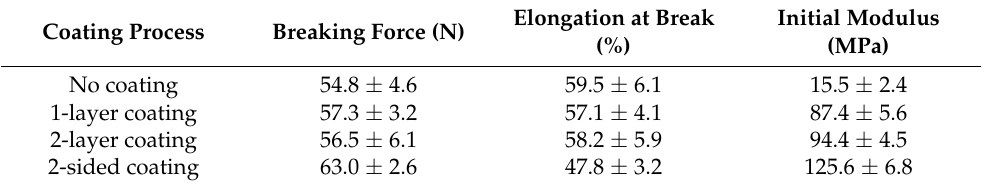
Table 2. Tensile properties of nonwoven and composites from various coating processes.